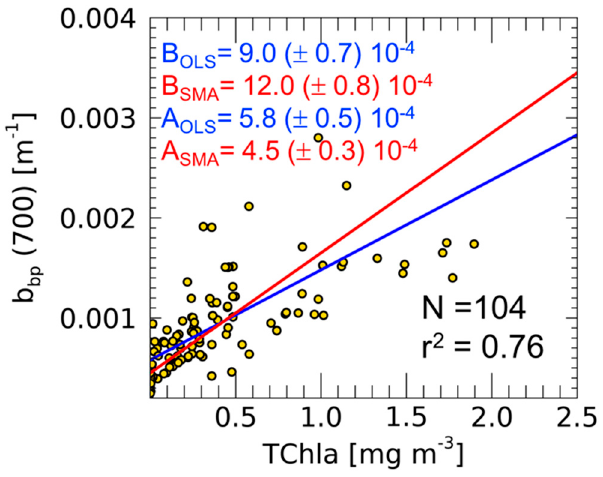
Figure 2. Scatter-plot and linear fit (continuous lines) calculated with ordinary least square (OLS) (blue) and standard major axis (SMA) (red) methods in the TChla-b bp relationship at the BOUSSOLE site. For both the coefficients, intercepts (A) and slopes (B), the standard errors are also indicated.